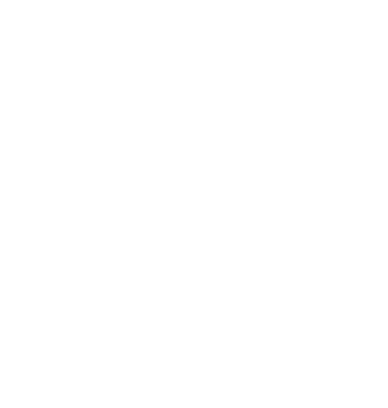
Table 3. Presents the kernel size associated with the ResNet-32